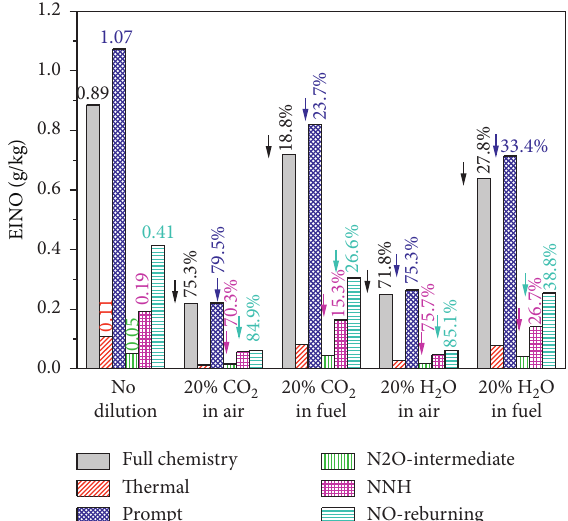
Figure 10: The percentages of EINO reduction by 20% H 2 O and 20% CO 2 dilution in the air and fuel side of CH 4 /air counterflow diffusion flame: a s � 50s − 1 , L � 2cm,